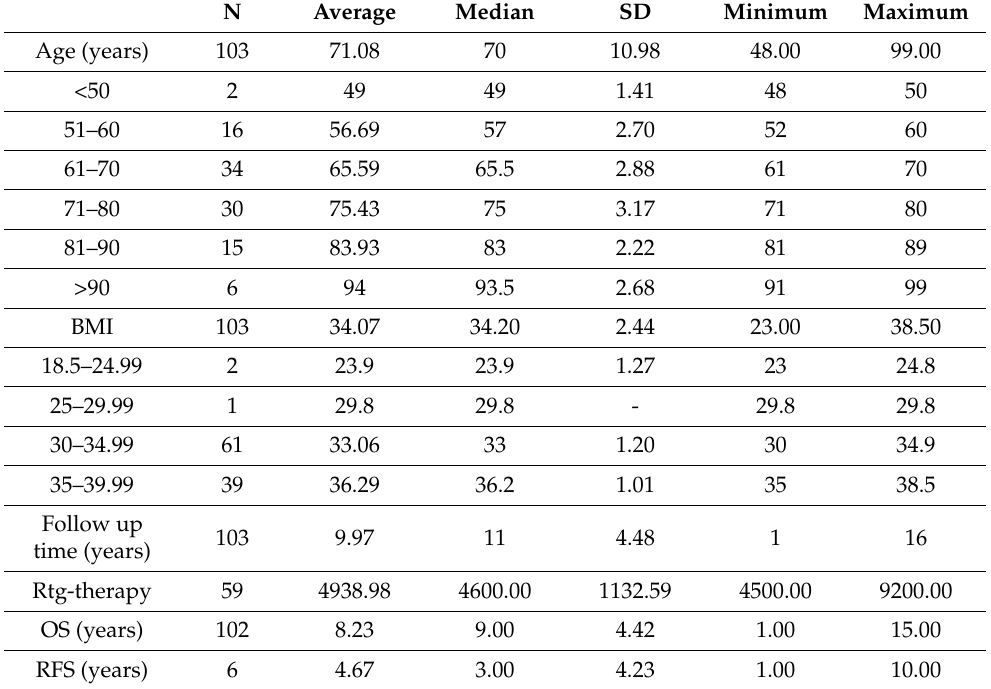
Table 1. General characteristics of the studied cohort.